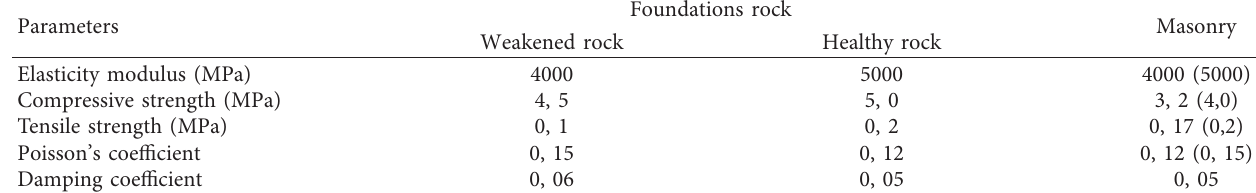
Table 1: Material parameters of rock and masonry used in the numerical analysis.